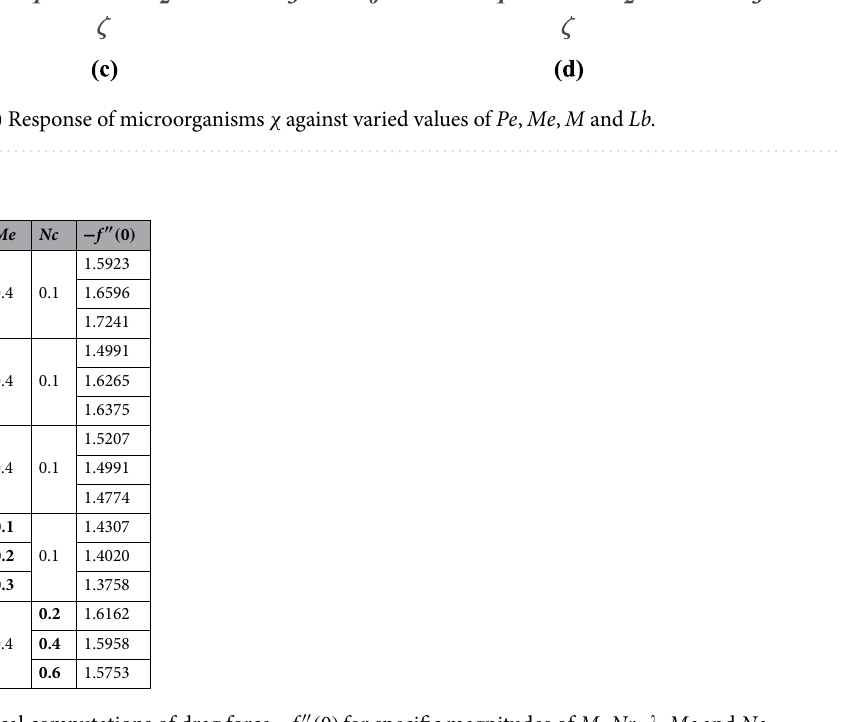
Table 2. Numerical computations of drag force